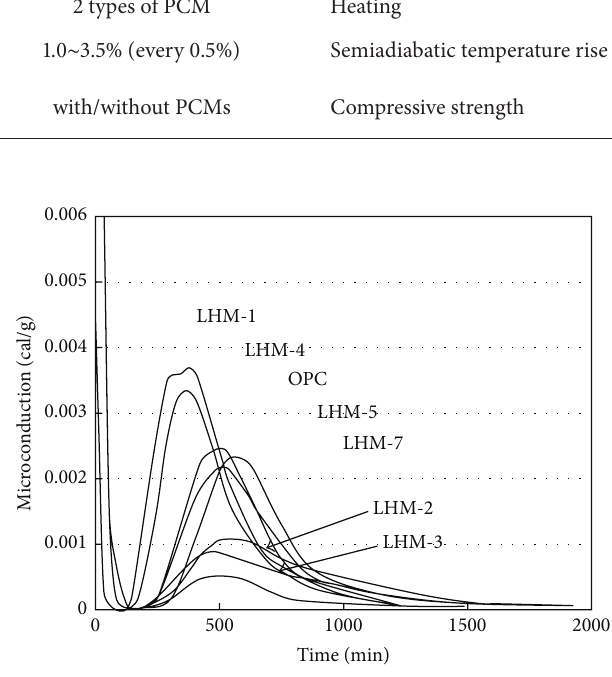
Figure 2: Microconduction measurements for cement paste with each